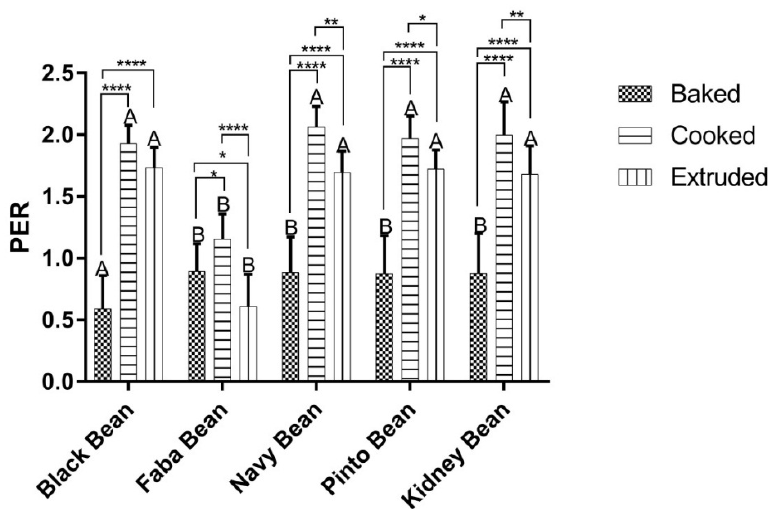
Figure 1. Protein Efficiency Ratio (PER) values of extruded, cooked and baked beans. Hatched bars indicate baked flour, horizontal bars are cooked flour and vertical bars are extruded flour. Mean ± SD ( n = 10). Data were analyzed via Two-Way ANOVA with Tukey’s post-hoc test. Comparisons within pulse class are designated by lines where * p < 0.05, ** p < 0.01, **** p < 0.0001. Significant differences between pulses classes, but within treatment, are designated by different letters, p < 0.05.